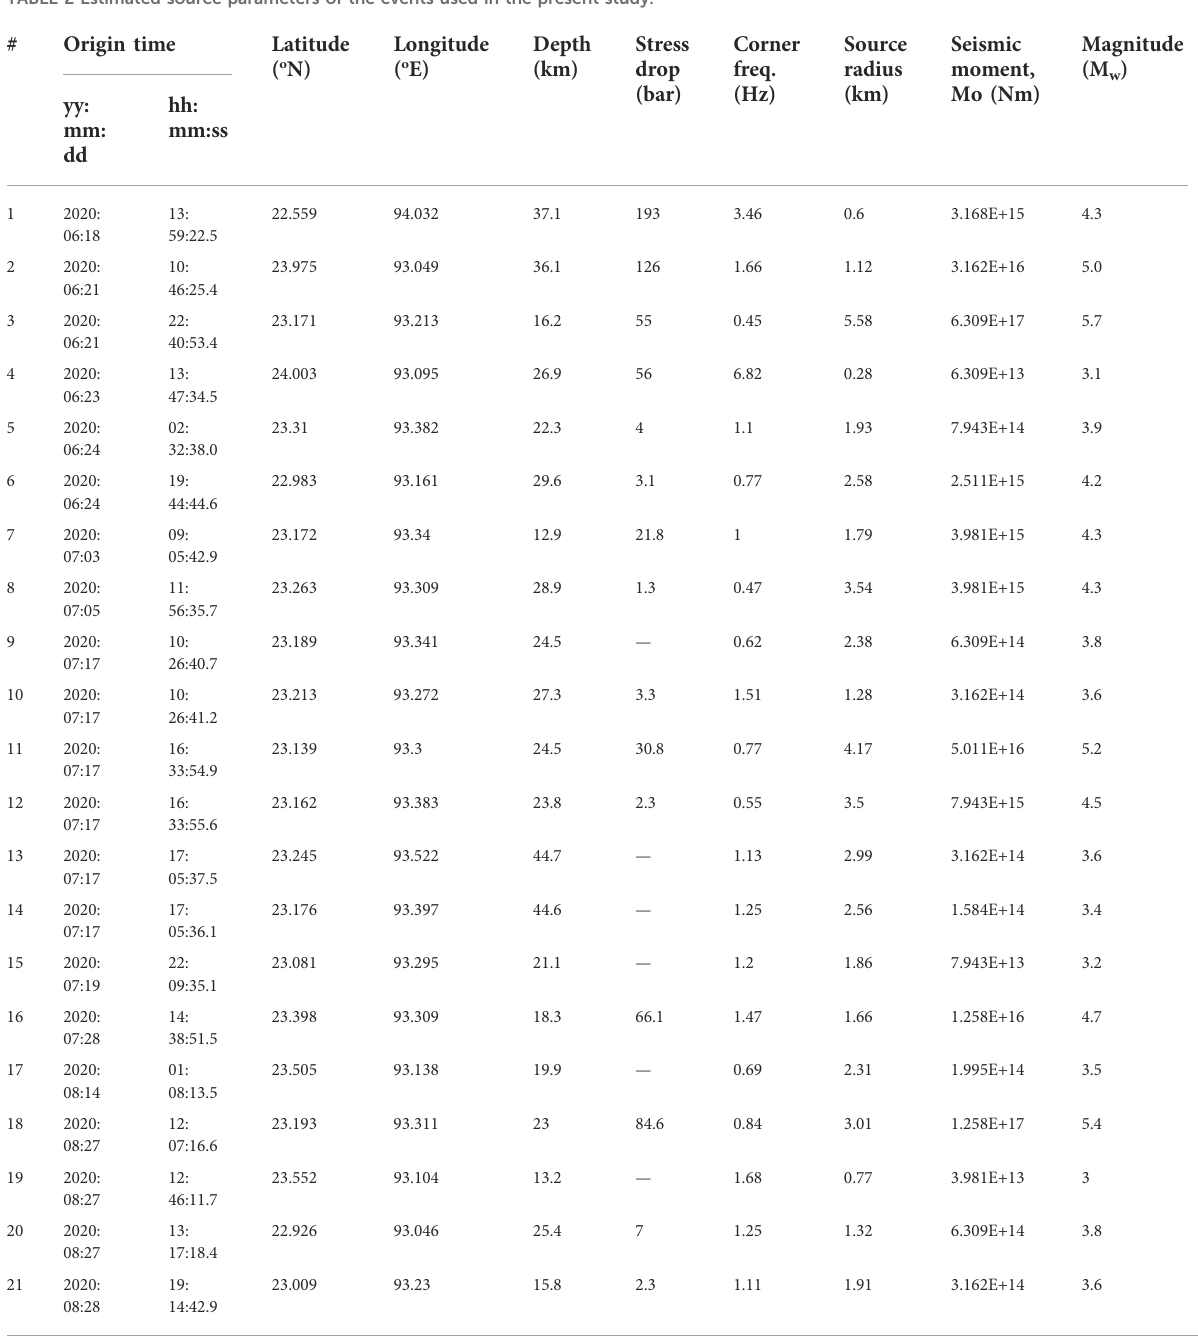
TABLE 2 Estimated source parameters of the events used in the present